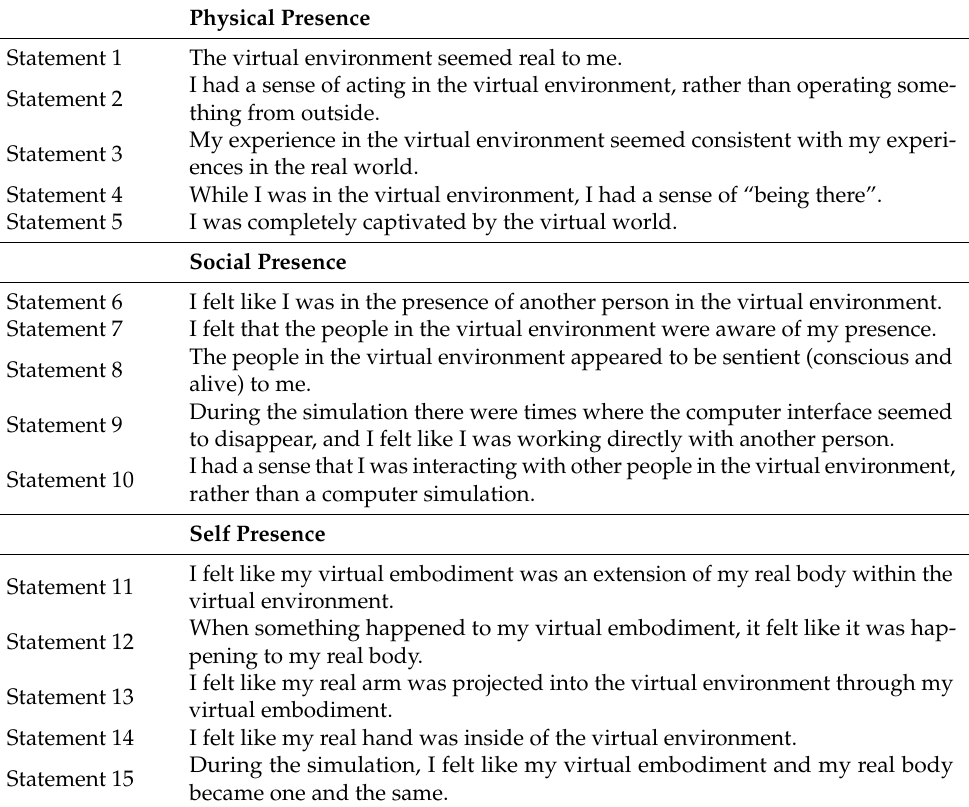
Table 1. All the statements in the Multimodal Presence Scale, organised by subscales for physical, social and self presence. After